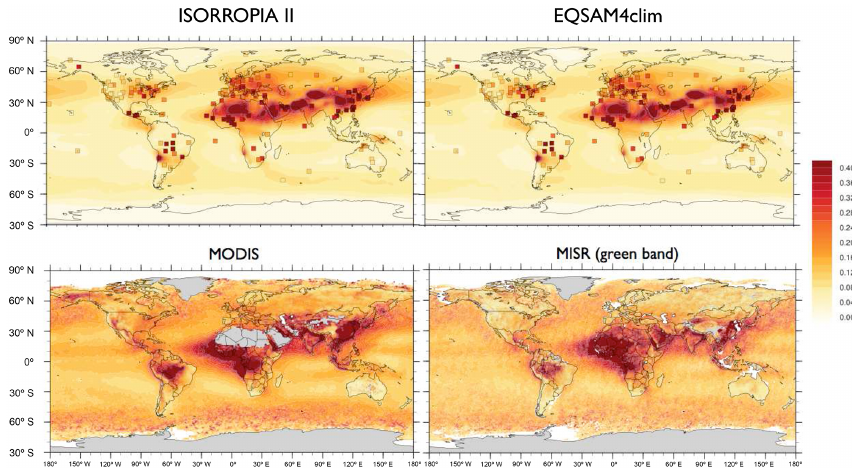
Figure 10. EMAC AOD vs. MODIS, MISR and AERONET (550nm, annual mean